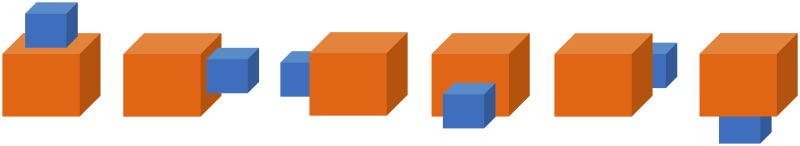
Possible situations that two cubes touch each other.